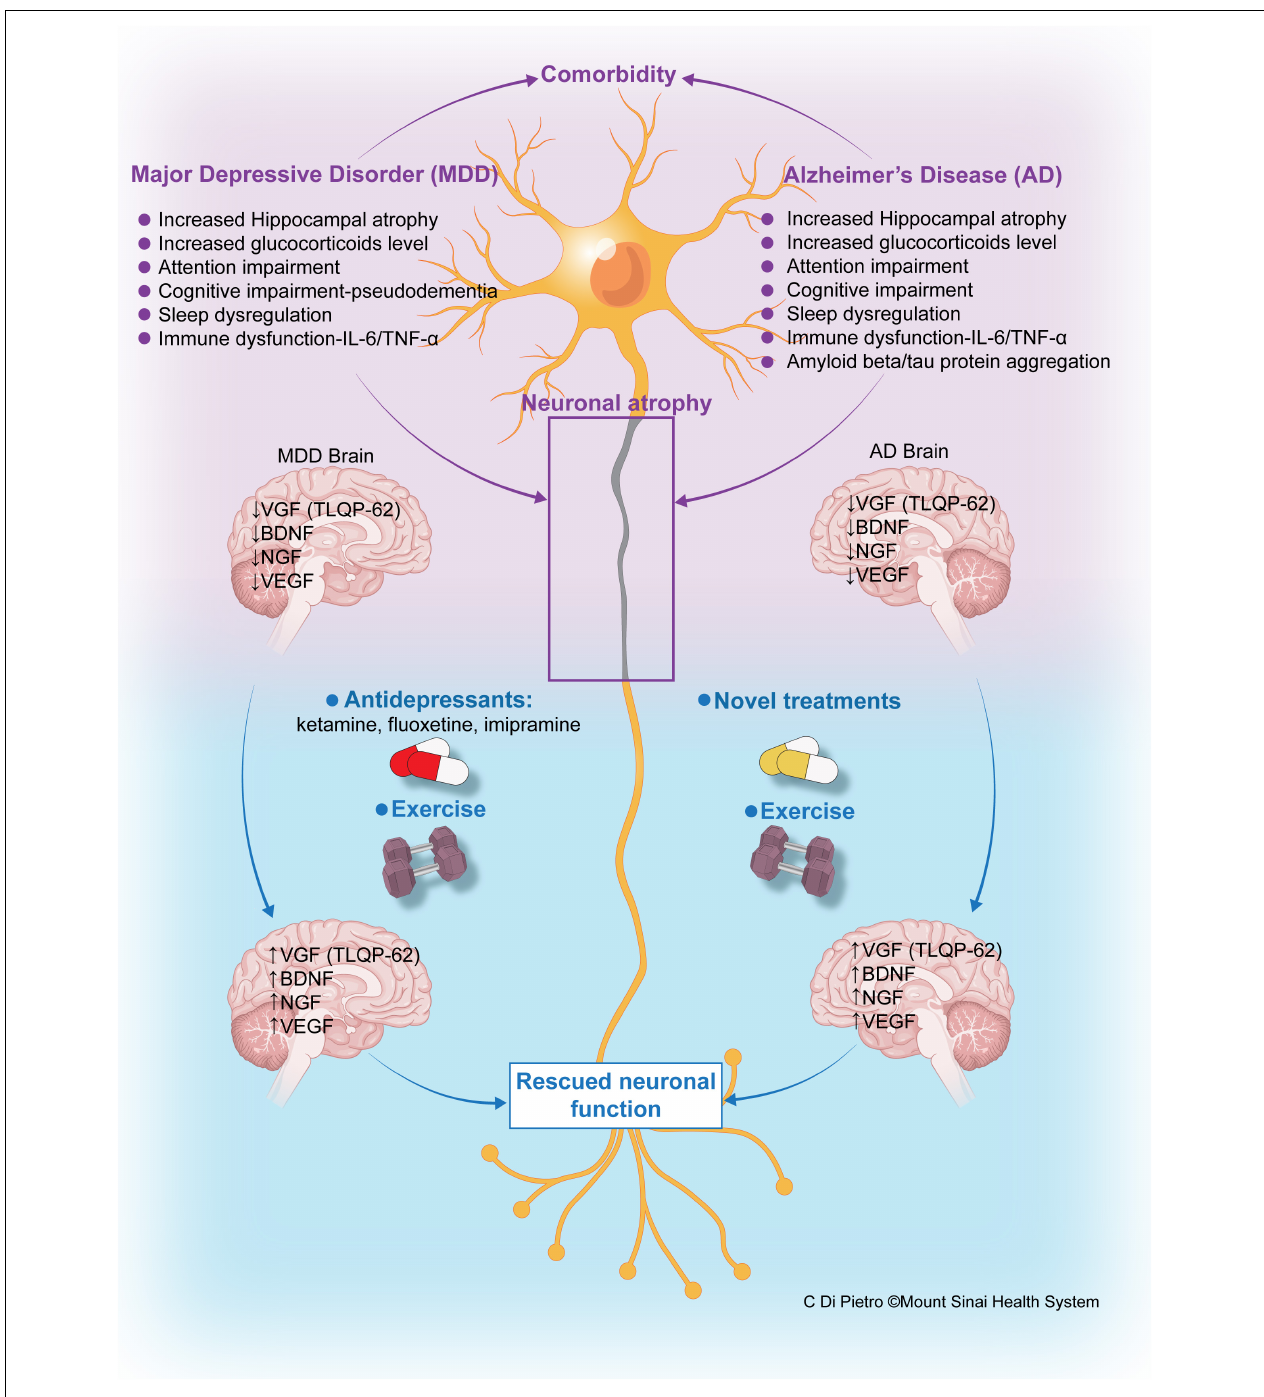
FIGURE 2 | Schematic of the Comorbidity of Major Depressive Disorder (MDD) and Alzheimer’s disease (AD), disorders that share pathophysiology, disease mechanisms, and potentially treatments. MDD and AD are often comorbid, in many cases sharing a number of pathophysiological features that are summarized in this figure. Cognitive disorders are a core feature of both MDD and AD, often referred to in MDD as pseudodementia or dementia of depression. Cognitive symptoms (particularly memory) in MDD can be reversible with treatment, or more commonly can persist following improvement or remission of depressive symptoms, progressing to overt dementia and AD (Rodrigues et al., 2014; Perini et al., 2019). Immune and glucocorticoid dysfunction are common to AD and MDD, leading to neuronal atrophy, as depicted. Expression of neurotrophic growth factors, including BDNF, VEGF, and VGF, and neuropeptides, such as TLQP-62, is also reduced in both AD and MDD. Treatment with antidepressants and increased exercise increase the levels of neurotrophins in MDD, helping to rescue neuronal function. In AD, exercise and future novel therapeutics may be similarly utilized to increase levels of these neurotrophins and select downstream gene products (VGF), halting the progression of neurodegenerative